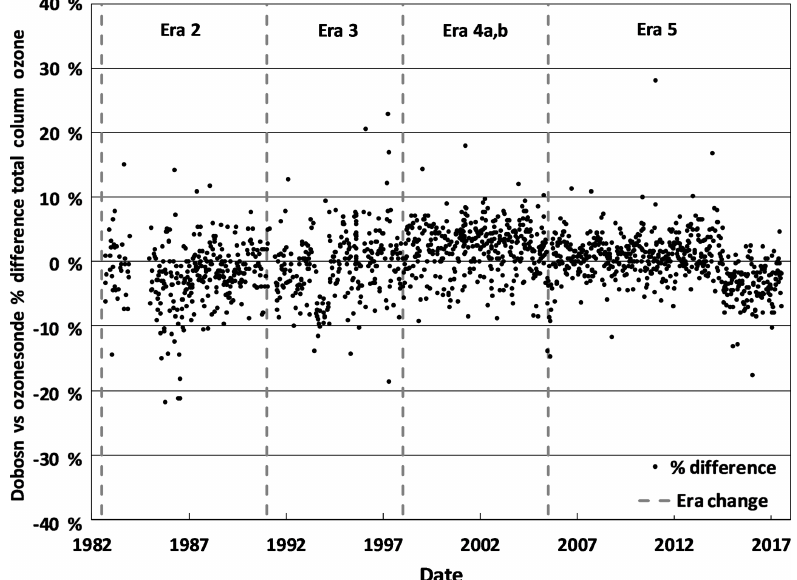
Figure 11. Hilo Dobson vs. ozonesonde total column ozone comparison.